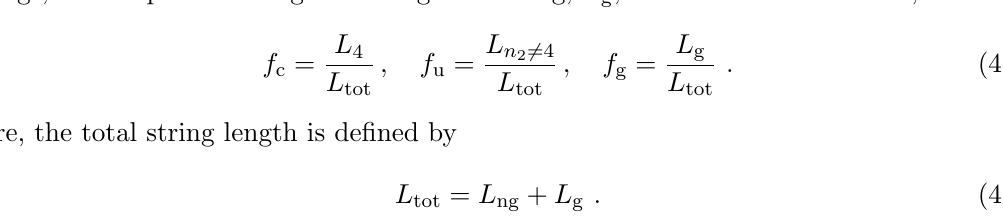
, for ( q 1 ; q 2 ; (cid:17) 2 =(cid:17) 1 ) = (1 ; 4; 0 : 2